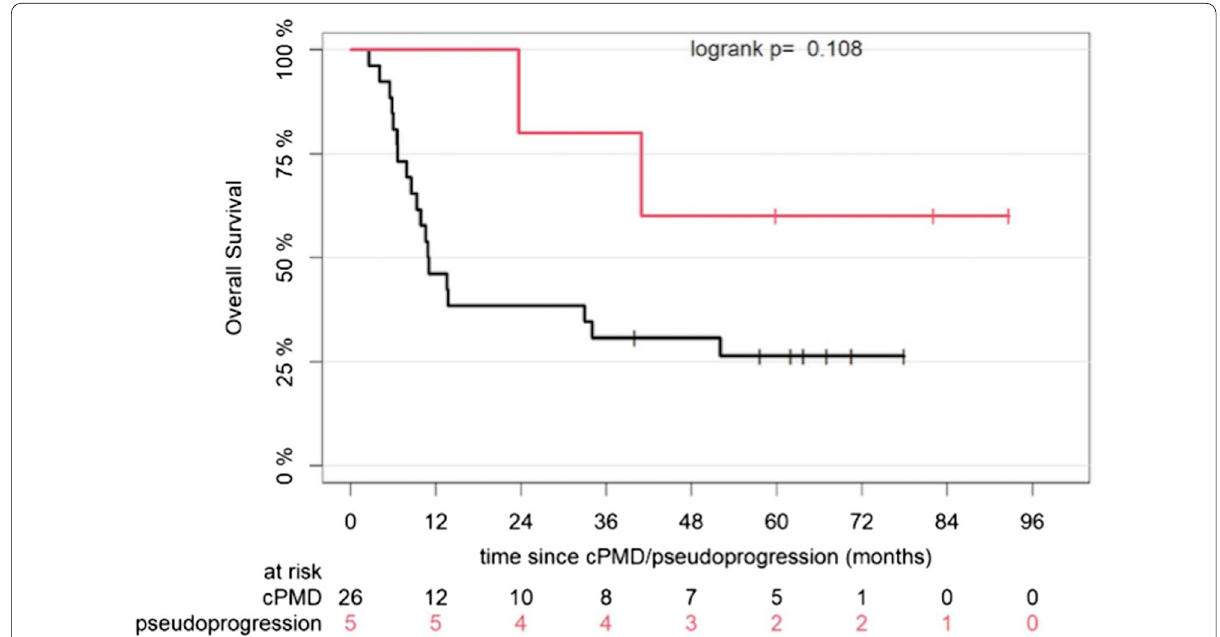
Fig. 3 Kaplan–Meier estimates of OS according to response pattern after application of EORTC. The numbers of patients at risk in each group and for the respective time‑points are shown below the plots. cPMD, confirmed progressive metabolic